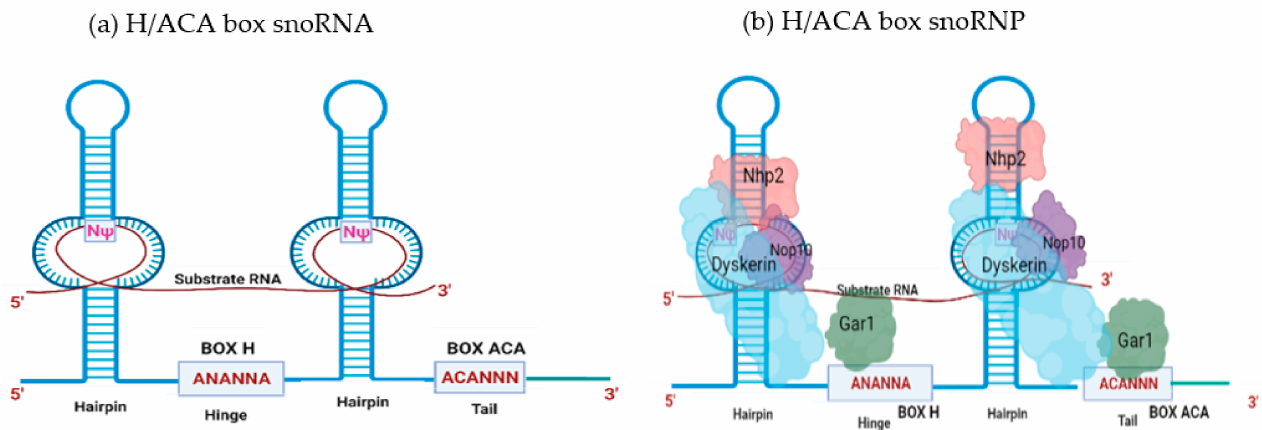
Figure 2. The H/ACA snoRNA structural features and associated protein cohort: ( a ) The H/ACA snoRNA family is characterized by two hairpins separated by the hinge region. H/ACA comprises box H and box ACA, the two conserved motifs, which are located in the hinge region and the 3 (cid:48) end, respectively. The psuedouridylation pocket is present in each hairpin of the H/ACA snoRNA that forms the interaction interface for target RNAs (shown in red) and is the site of psuedouridylation (N Ψ ) of the substrate RNA. ( b ) The proteins DKC1(cyan), Nop10(violet), Gar1 (Green), and Nhp2 (pink) associate with H/ACA snoRNA to form the H/ACA SnoRNP complex. DKC1 (the pseudouridine synthase dyskerin) directly promotes psuedouridylation. Additionally, Nop10 and Nhp2 have been demonstrated to be critical for H/ACA stability and function. Moreover, GAR1 has been shown to enhance the catalytic activity of dyskerin and to facilitate the release of substrate